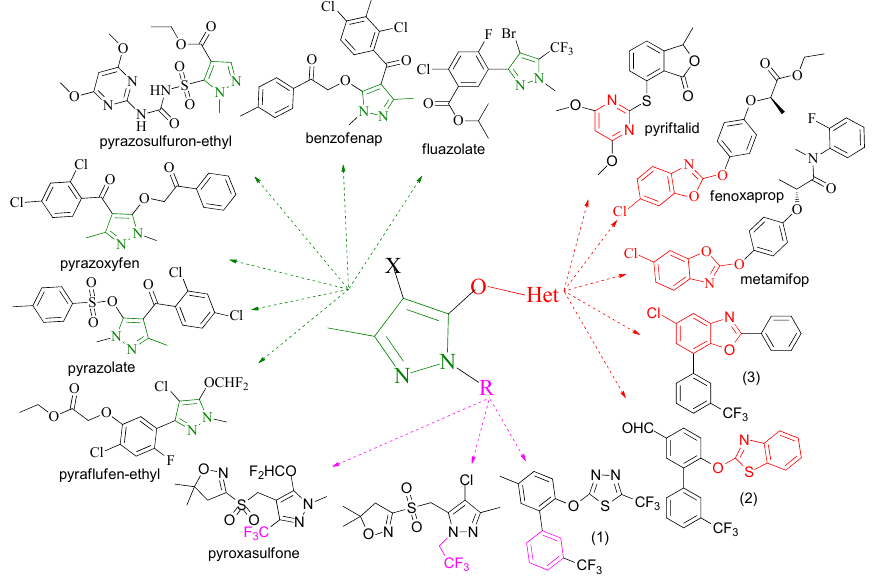
Figure 1. Structural importance of few of the molecules.